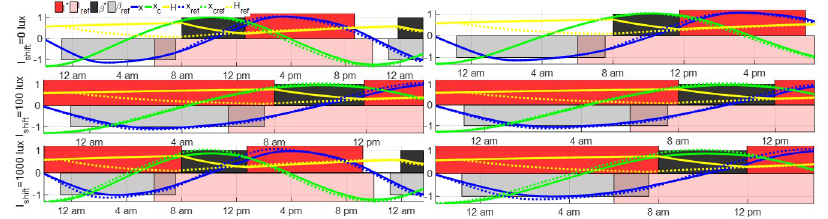
Fig 16. Minimum-time optimal entrainment of shift workers with night shift from 10 pm to 8 am with controllable sleep schedule and different working light intensity I shift , maximum light intensity I max = 1000 lux (left) and I max = 10000 lux (right). The minimum entrainment time of these cases is given as 17.68 hours for I shift = 0 lux and I max = 1000 lux, 6.47 hours for I shift = 100 lux and I max = 1000 lux, 17.62 hours for I shift = 1000 lux and I max = 1000 lux, 11.38 hours for I shift = 0 lux and I max = 10000 lux, 5.60 hours for I shift = 100 lux and I max = 10000 lux and 6.96 hours for I shift = 1000 lux and I max = 10000 lux,